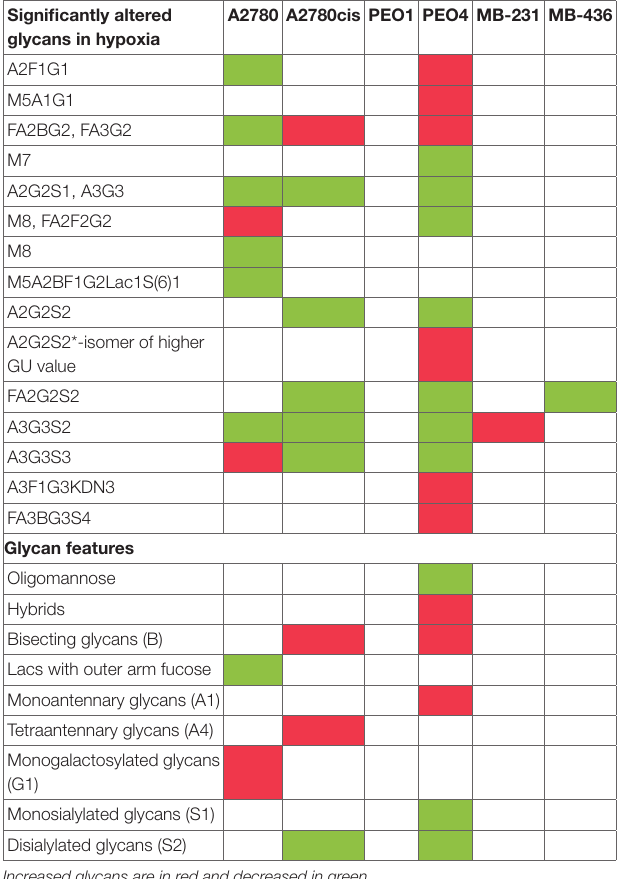
TABLE 1 | Summary of glycomic changes in all cell